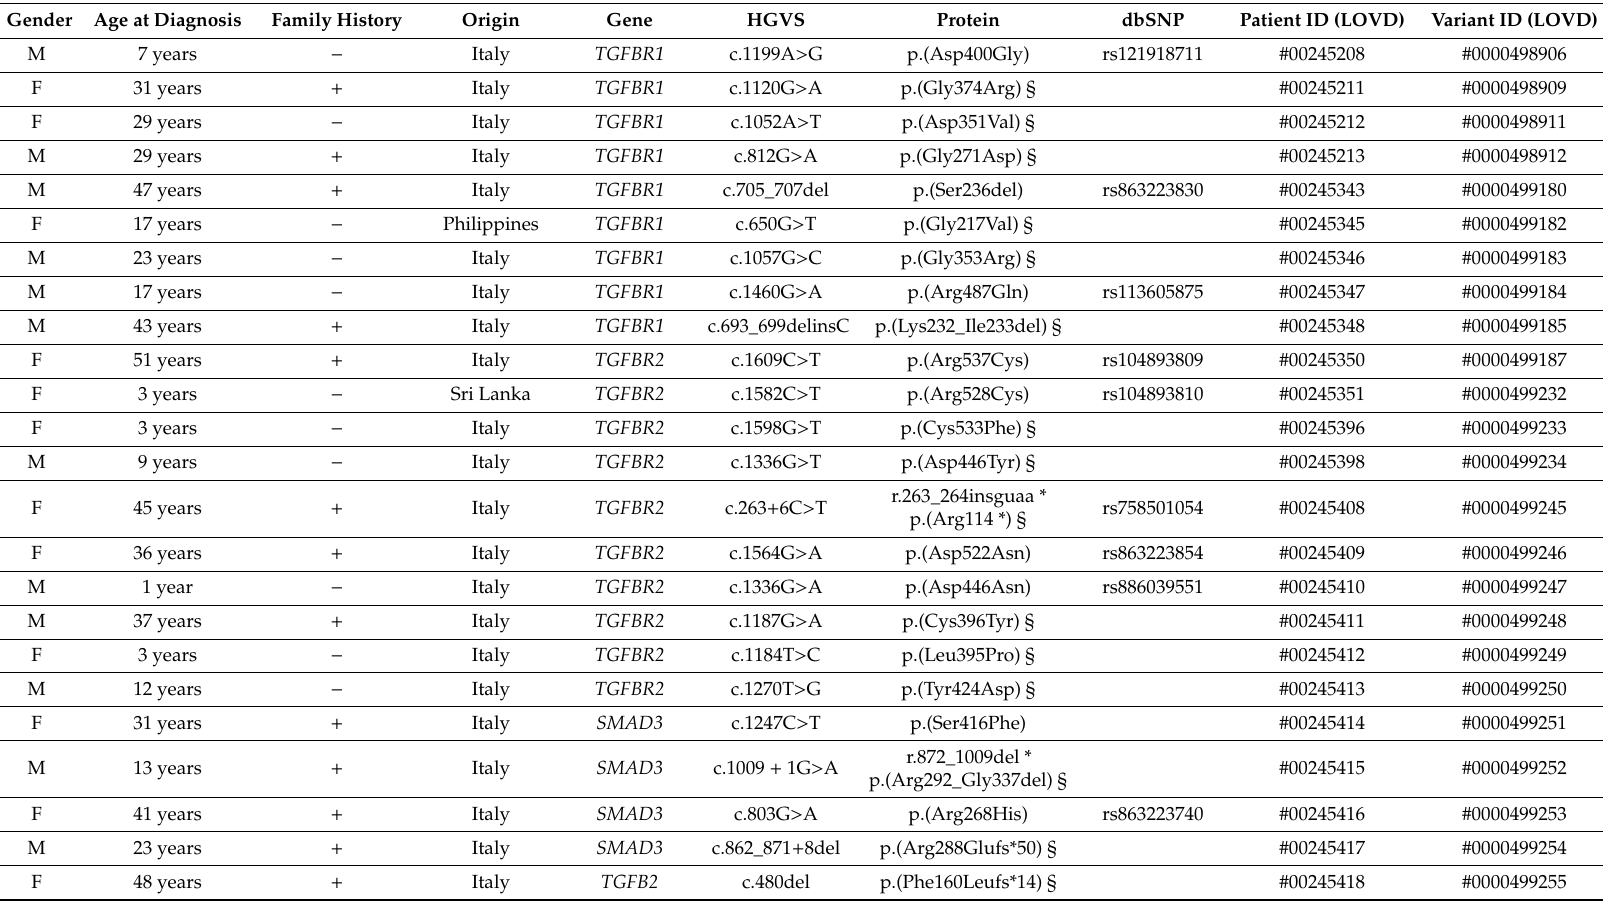
Table 2. List of variants identified in this study in each gene and molecular